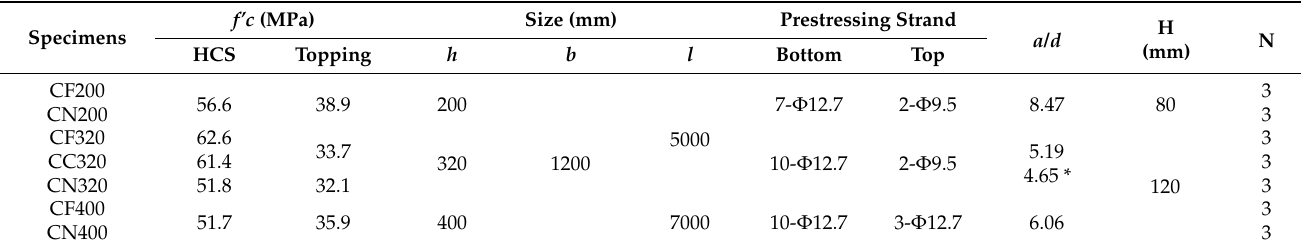
Table 2. Properties of specimens.